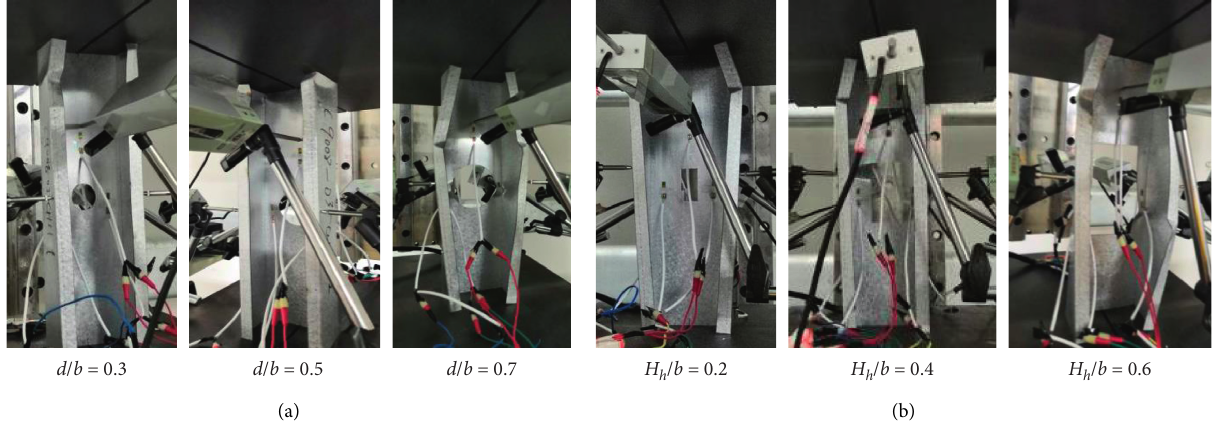
d / b = 0.3 d / b = 0.5 Figure 8: Comparison of the buckling mode for section 9008 series with different dimensions of holes. (a) Specimens with circular holes. (b) Specimens with rectangular